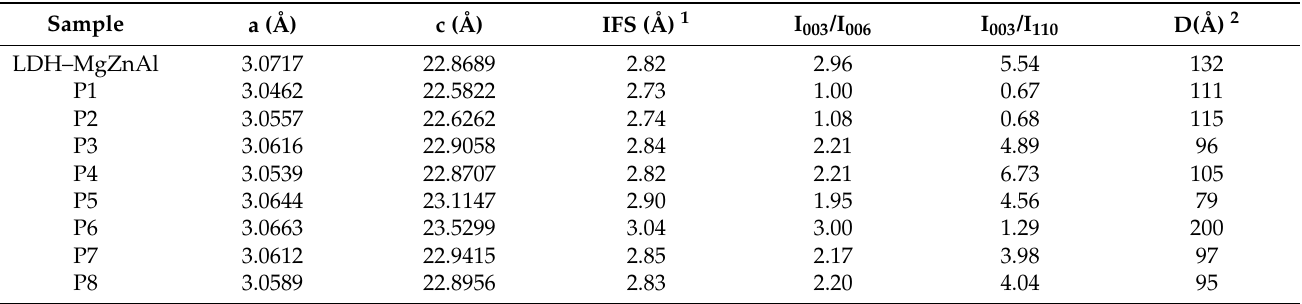
Table 2. Network parameters determined from the X-ray diffractograms for the bare MgZnAl LDH and P1–P8